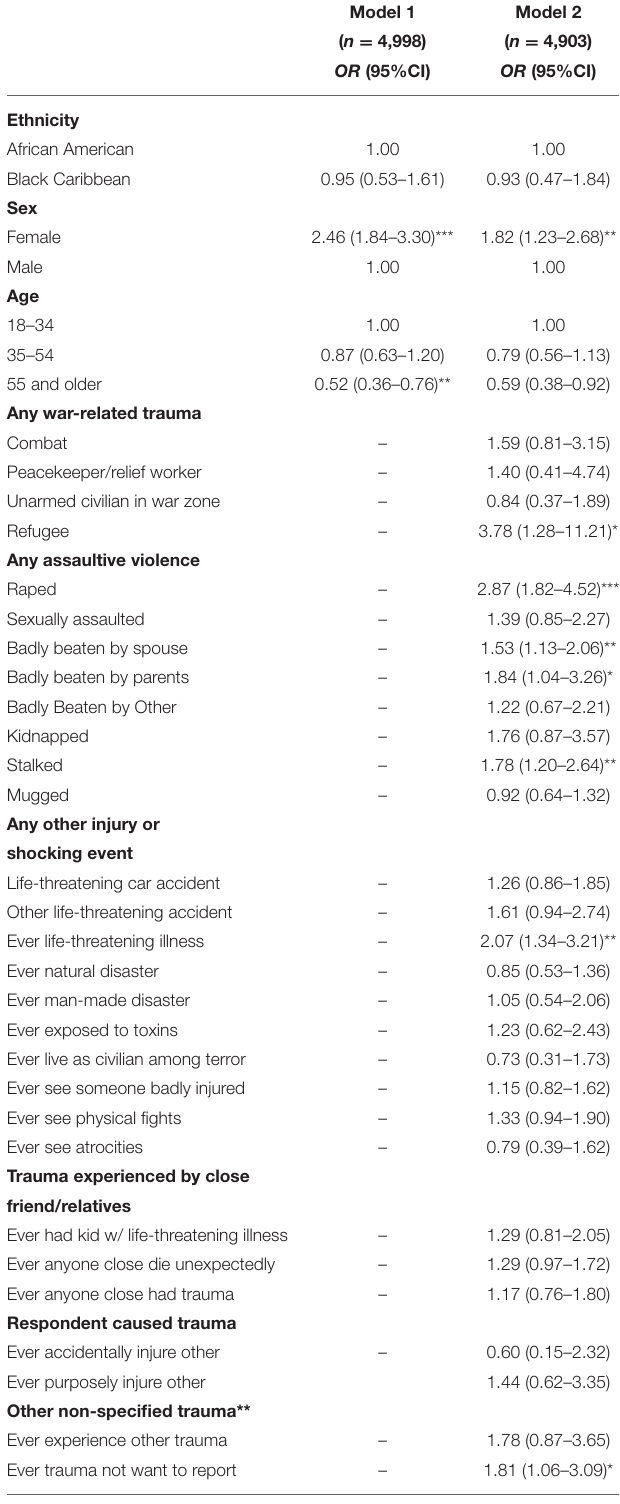
TABLE 3 | Logistic regression models of post-traumatic stress disorder among Black Americans by ethnicity, sex, age and trauma exposure